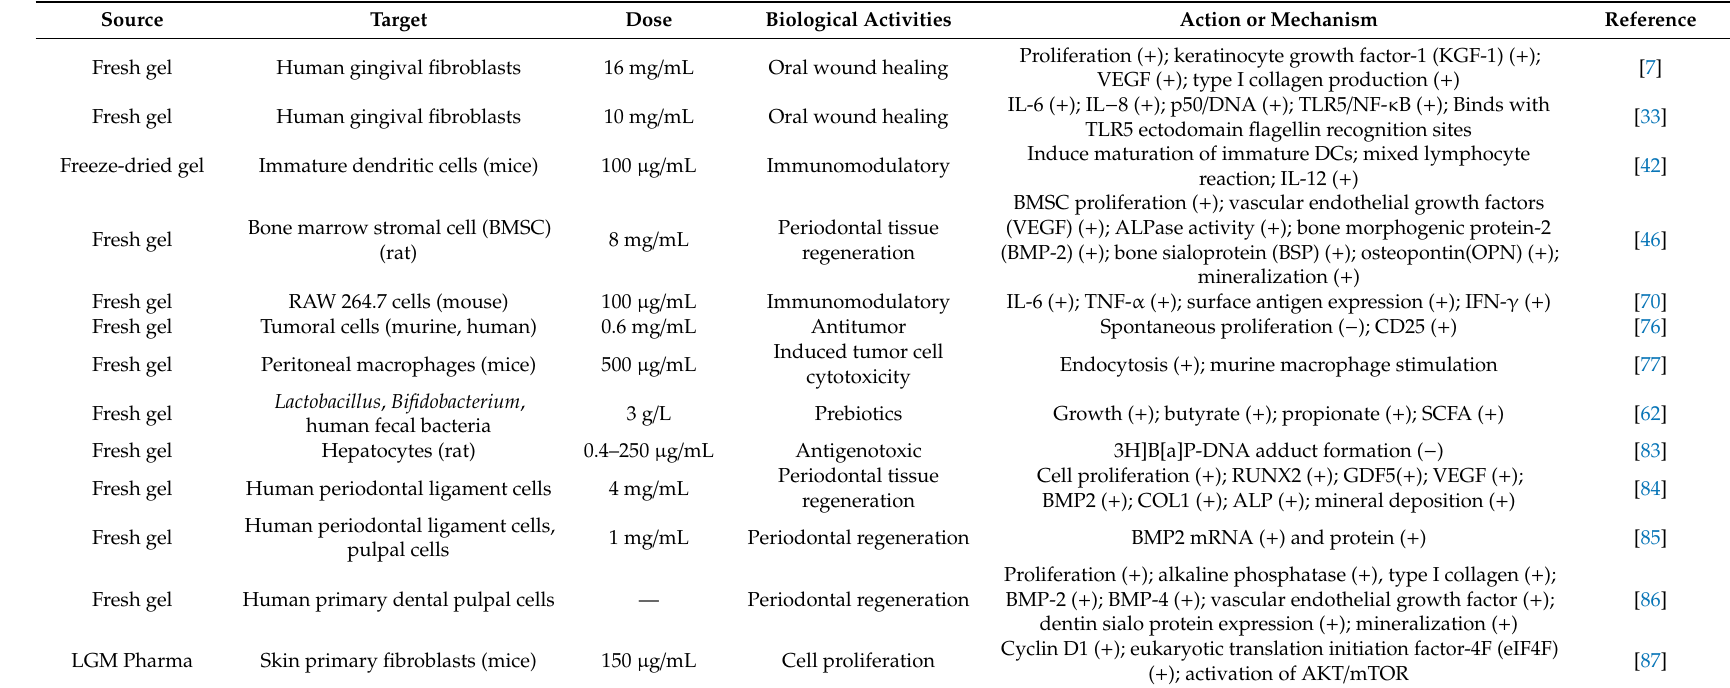
Table 2. Biological activity of acemannan in